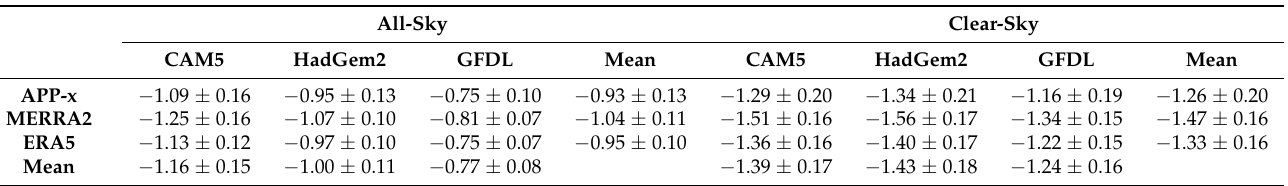
Table 2. Arctic sea ice radiative forcing (W · m − 2 ), averaged over 1982–2020 and three kernels’ esti- mates for three albedo products (APP-x, MERRA2, and ERA5). All-Sky Clear-Sky